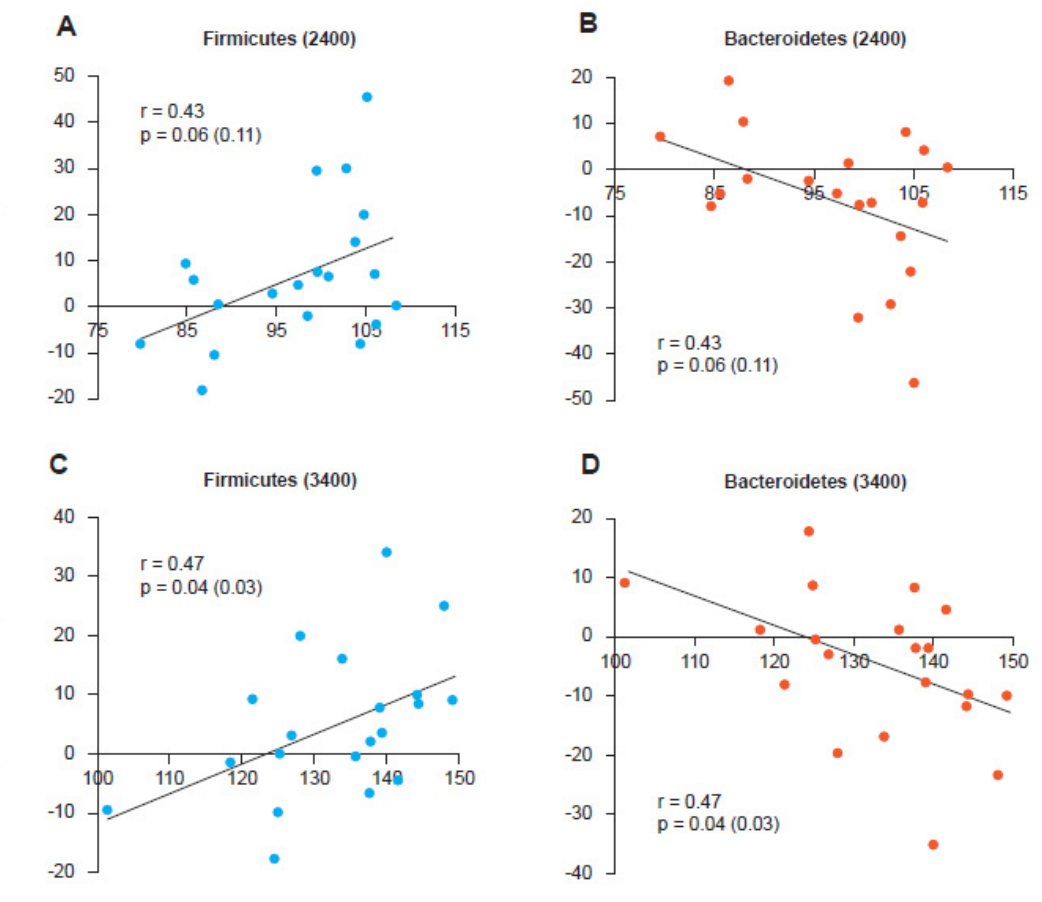
Figure 1. Firmicutes and Bacteroidetes trends as the calories in the diet vary with respect to an isocaloric condition for the individual regardless of their phenotype (obese or lean). Firmicutes variation with 2400 kcal/day ( A ) and 3400 kcal/day ( C ) diets. Bacteroidetes variation with diet at 2400 kcal/day ( B ) and at 3400 kcal/day ( D ) [30].